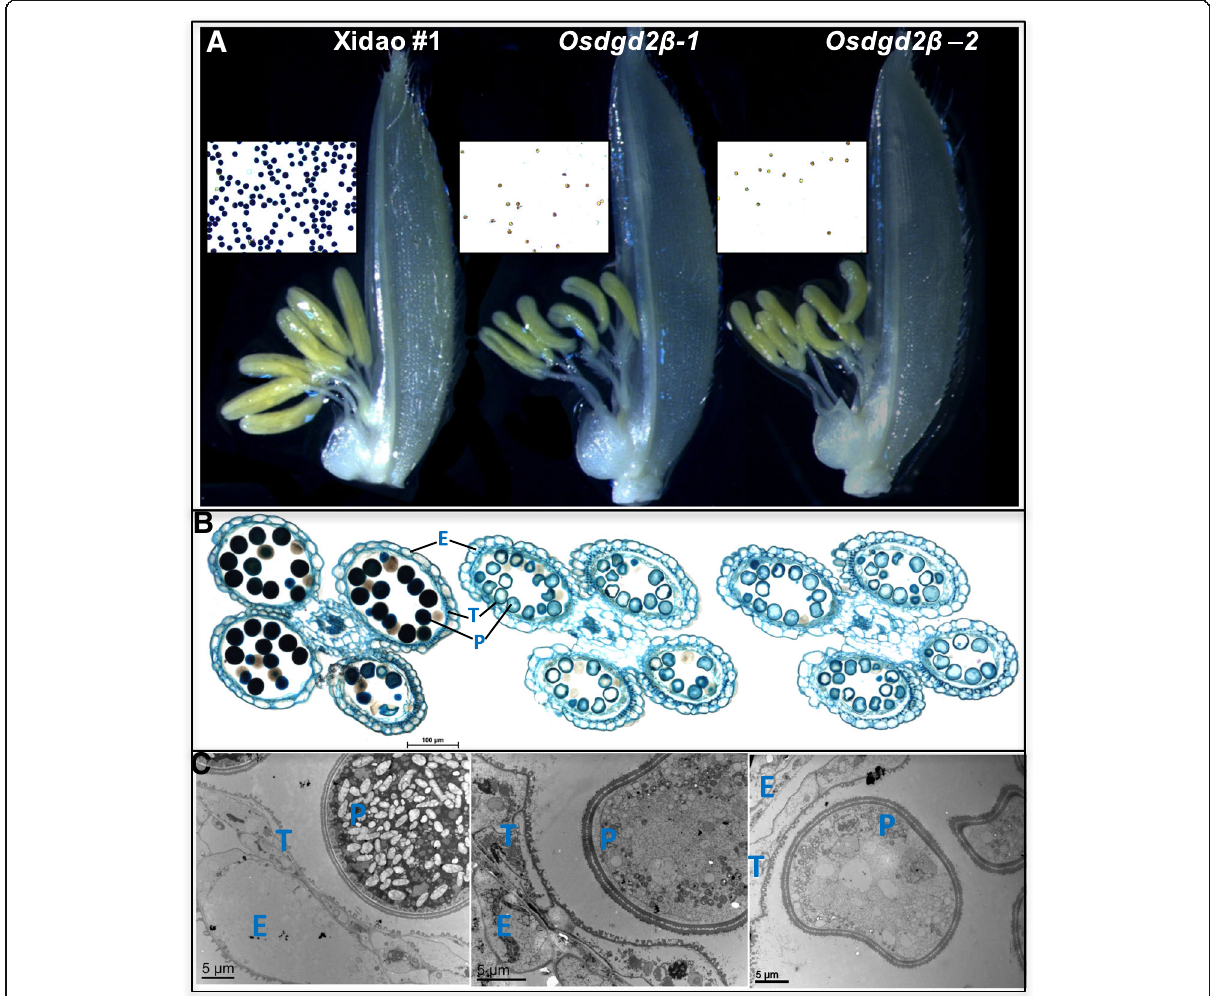
Fig. 5 Phenotypic observation of anther of wild-type cultivar Xidao #1 and its mutants osdgd2 β -1 and osdgd2 β -2 . a spikelet with palea removed showing differences in anther with pollen stained with 1% IKI (iodine potassium iodide) in the middle, b Microscopy of cross section of anthers stained with 0.5% toluidine blue, and c Transmission Electron Microscopy (TEM) @4000X magnification. E epidermis, T tapetum, P